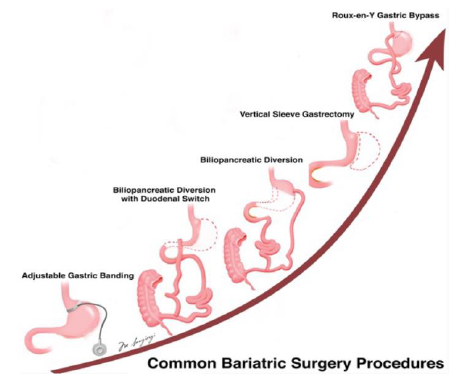
Figure 1. Overview of different bariatric surgery options. The most effective options in weight reduction are the Roux-en-Y gastric bypass and sleeve gastrectomy. Arrow indicates an increase in efficacy.